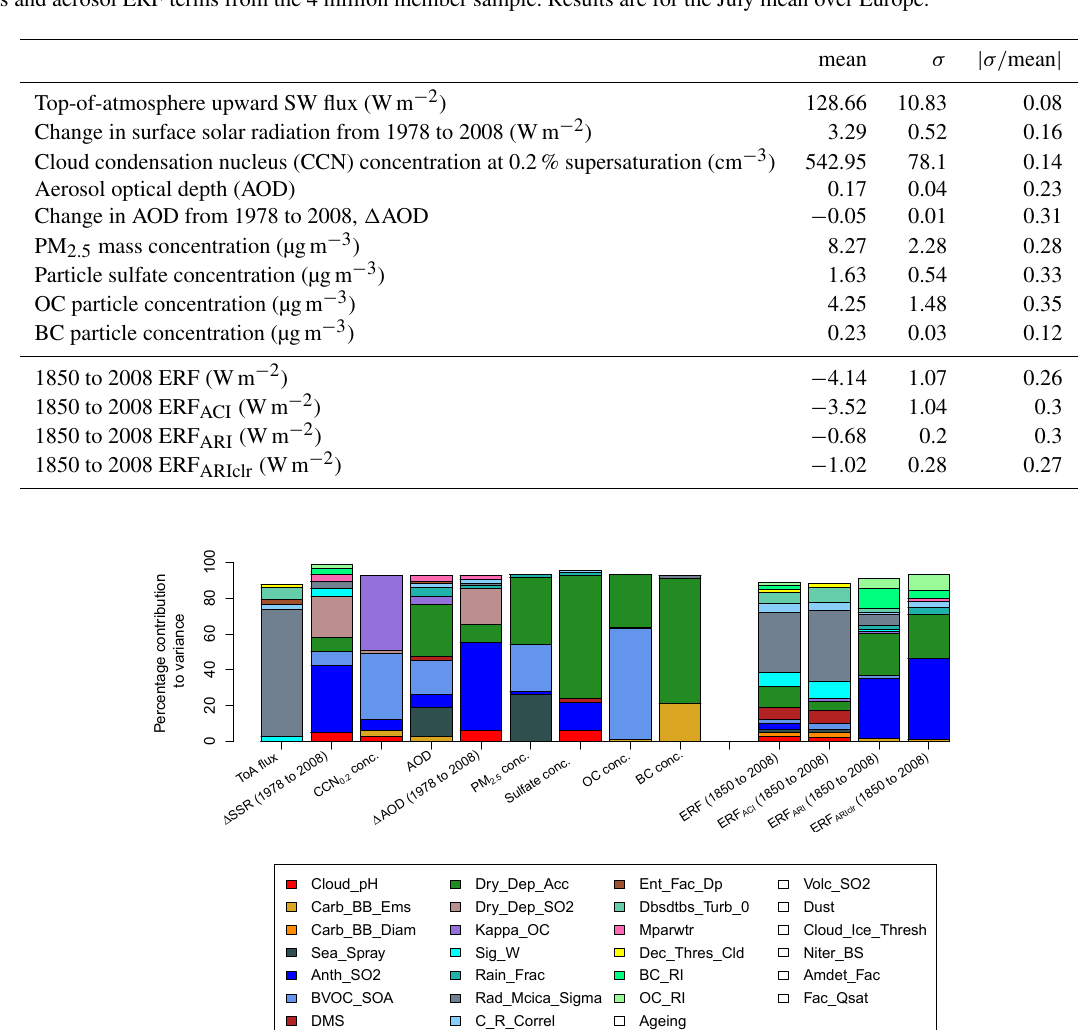
Table 4. Mean, standard deviation ( σ ) and absolute relative standard deviation ( | σ/ mean | ) of the calculated uncertainty in the aerosol quantities and aerosol ERF terms from the 4 million member sample. Results are for the July mean over Europe.